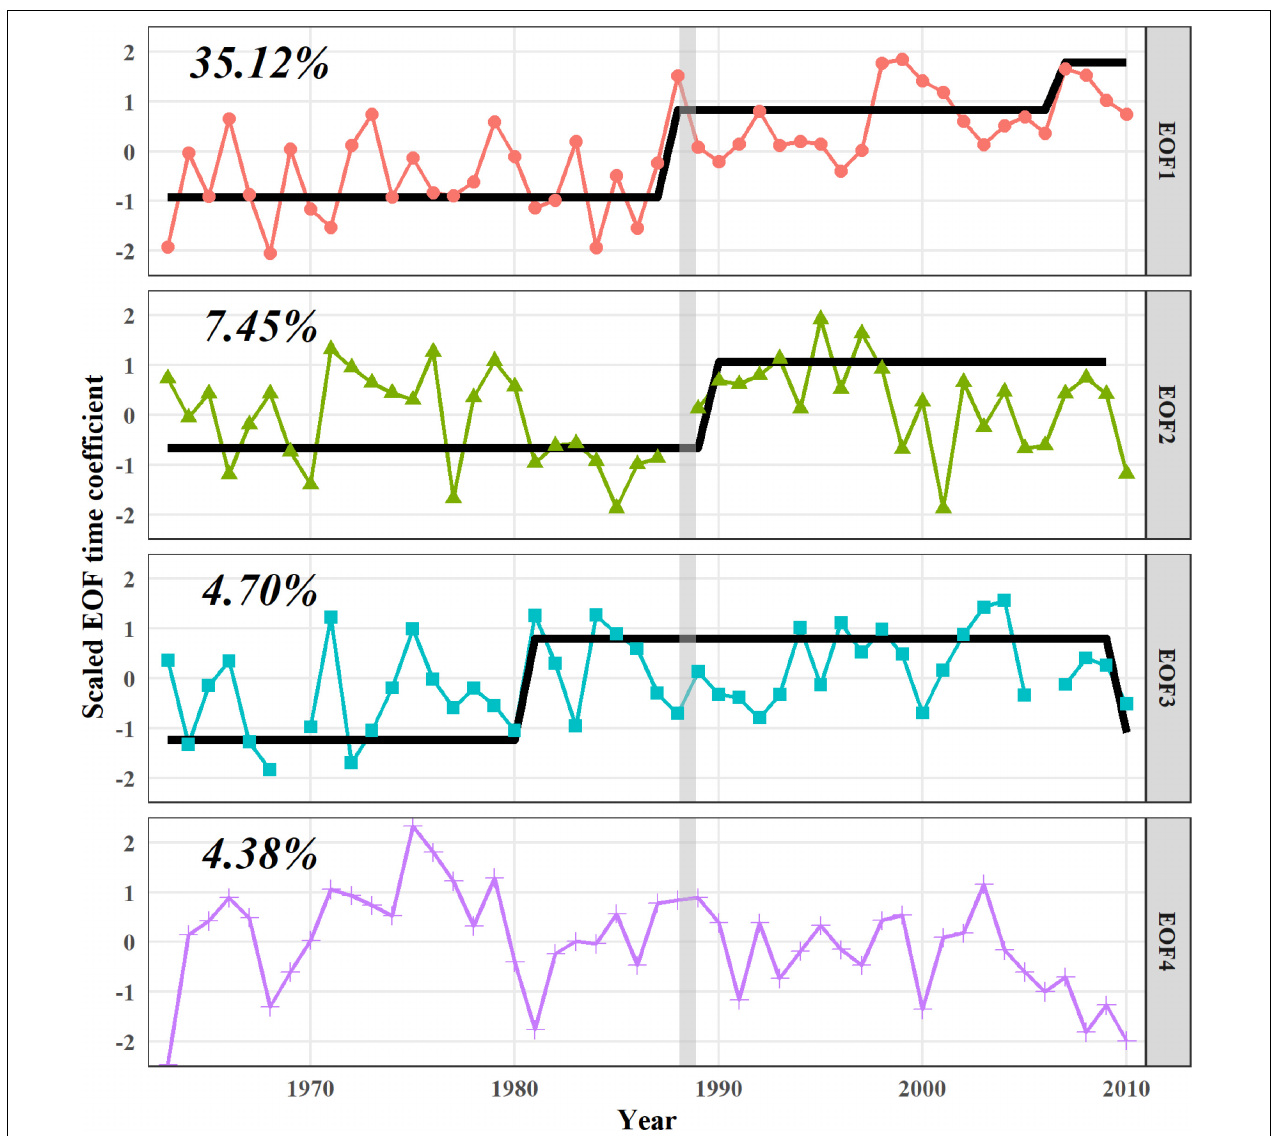
FIGURE 4 | Trajectories of the first four modes of empirical orthogonal functions (EOFs). Numbers indicate the percentage of variance explained by each EOF. Black lines represent regime means calculated by STARS, and gray lines represent the concentrated step-like changes in the late 1980s in contrast to those in Figure 3